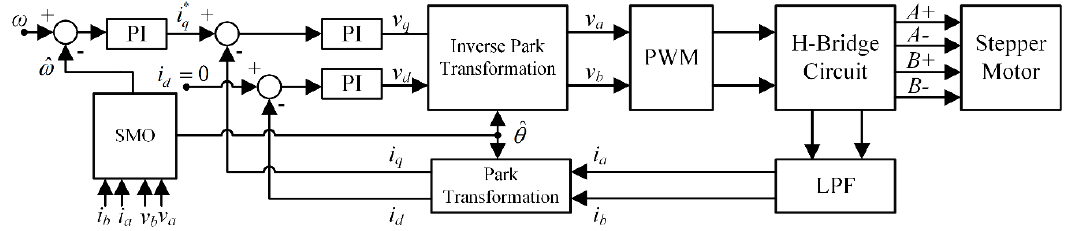
Figure 2. Block diagram of the conventional sensorless speed control of a stepper motor.